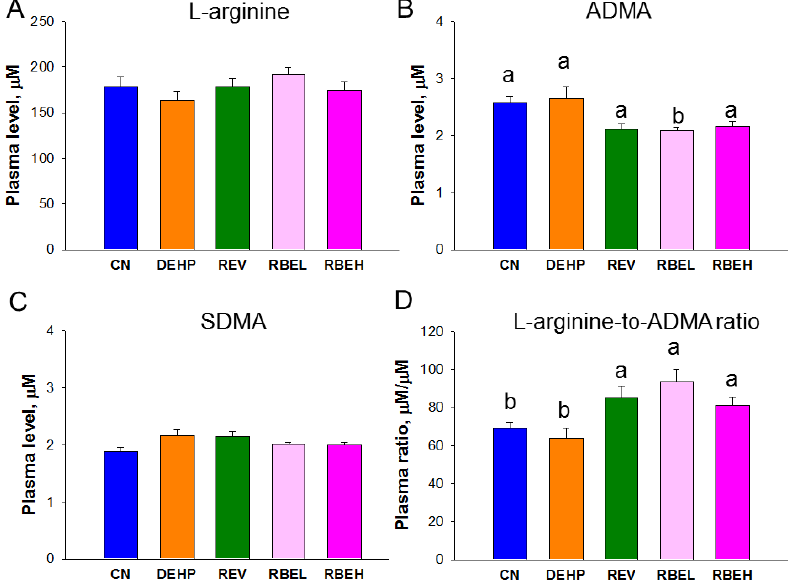
Figure 4. Effects of di-2-ethylhexylphthalate (DEHP), resveratrol (REV), and resveratrol butyrate ester (RBE) on plasma concentrations of ( A ) L-arginine, ( B ) asymmetric dimethylarginine (ADMA), ( C ) symmetric dimethylarginine (SDMA), and ( D ) the ratio of L-arginine-to-ADMA in offspring at 12 weeks of age. The letters a and b indicate the differences between the groups ( p < 0.05, one-way ANOVA with post hoc Tukey’s test); N = 8/group. Table 3. Plasma concentrations of SCFAs of male offspring at 12 weeks of age.